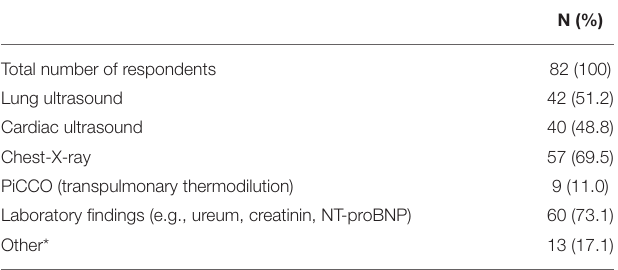
TABLE 3 | Tools (clinical, radiological and/or laboratory) used regularly diagnosing fluid